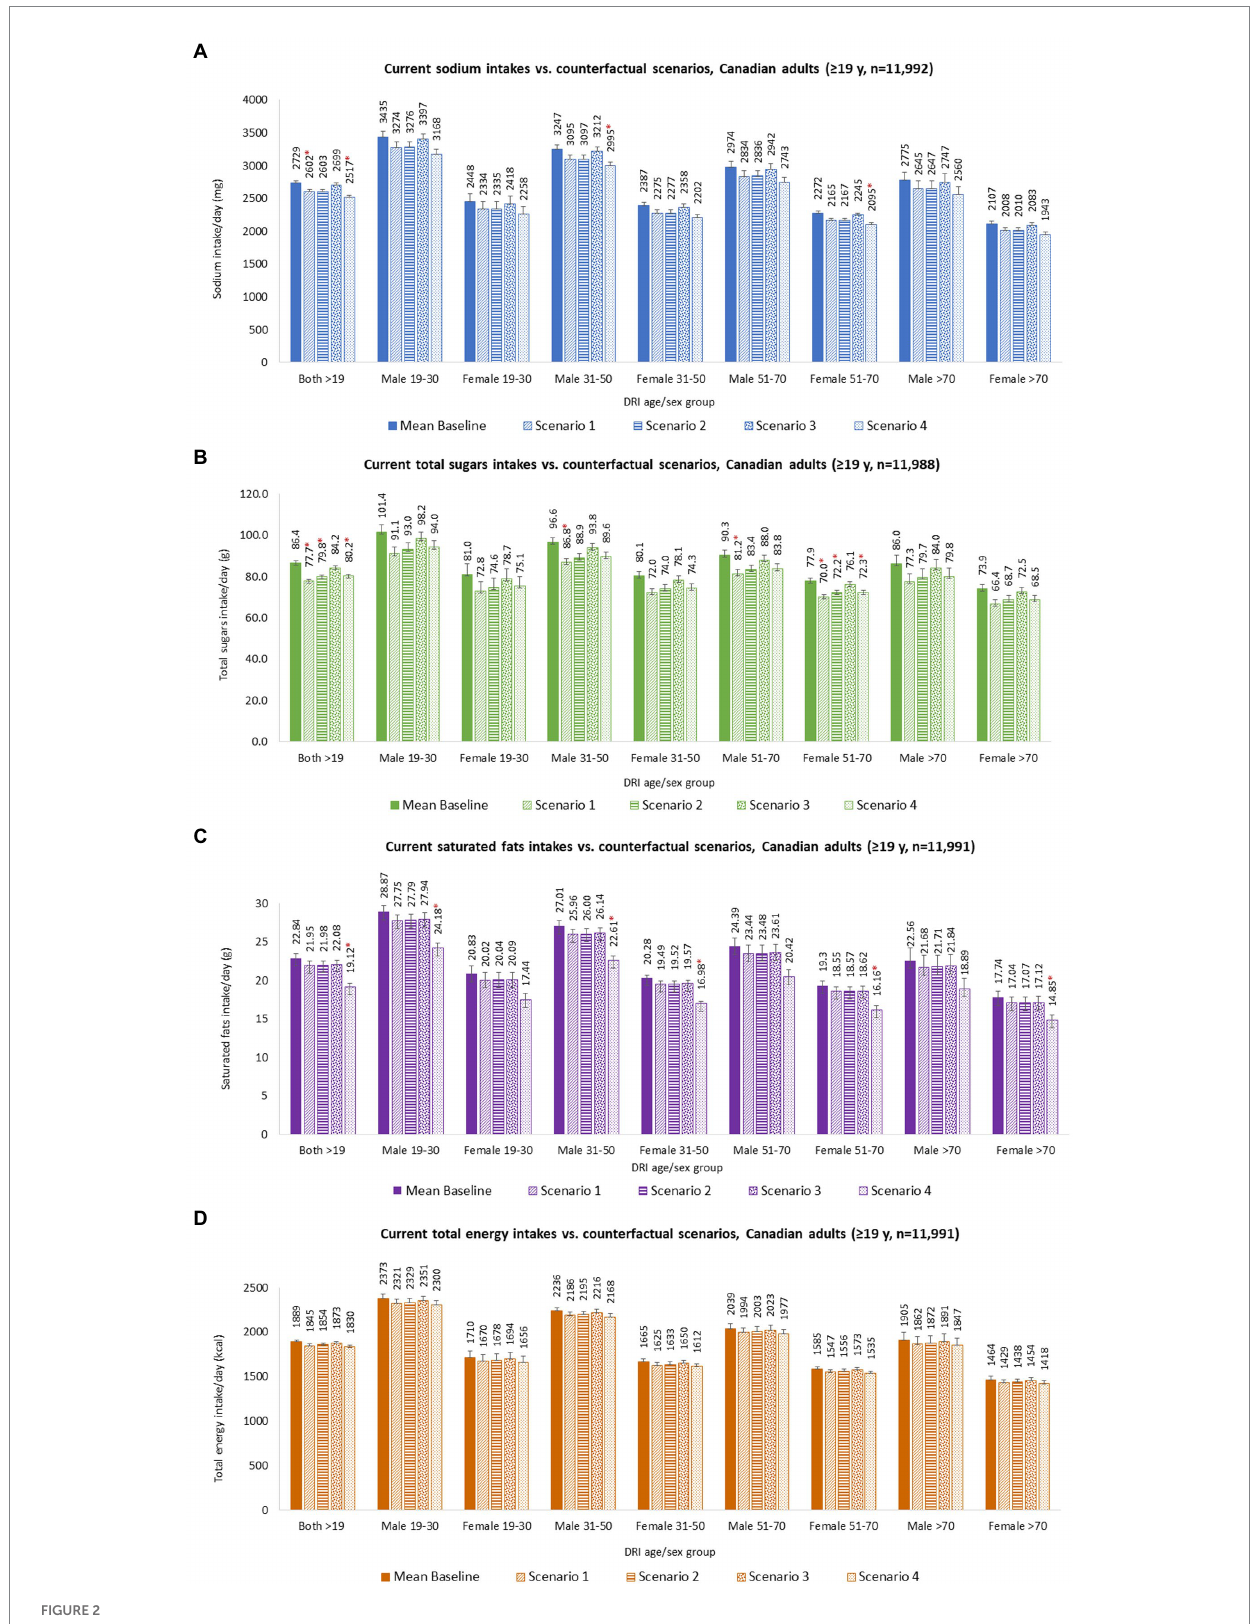
FIGURE 2 Nutrient intakes of Canadian adults ( ≥ 19 years), overall and by DRI age-sex groups, for baseline and under each counterfactual scenario. (A) Sodium intakes; (B) Total sugars intakes; (C) Saturated fats intakes; and (D) Total energy intakes. Baseline and counterfactual calorie and nutrient intakes were estimated using CCHS-Nutrition 2015 PUMF data (61, 63). Usual intakes were estimated using the National Cancer Institute (NCI) method (103), and analyses were adjusted for age, sex, dietary misreporting status, weekend/weekday, and sequence of dietary recall. d, day; g, grams; mg,